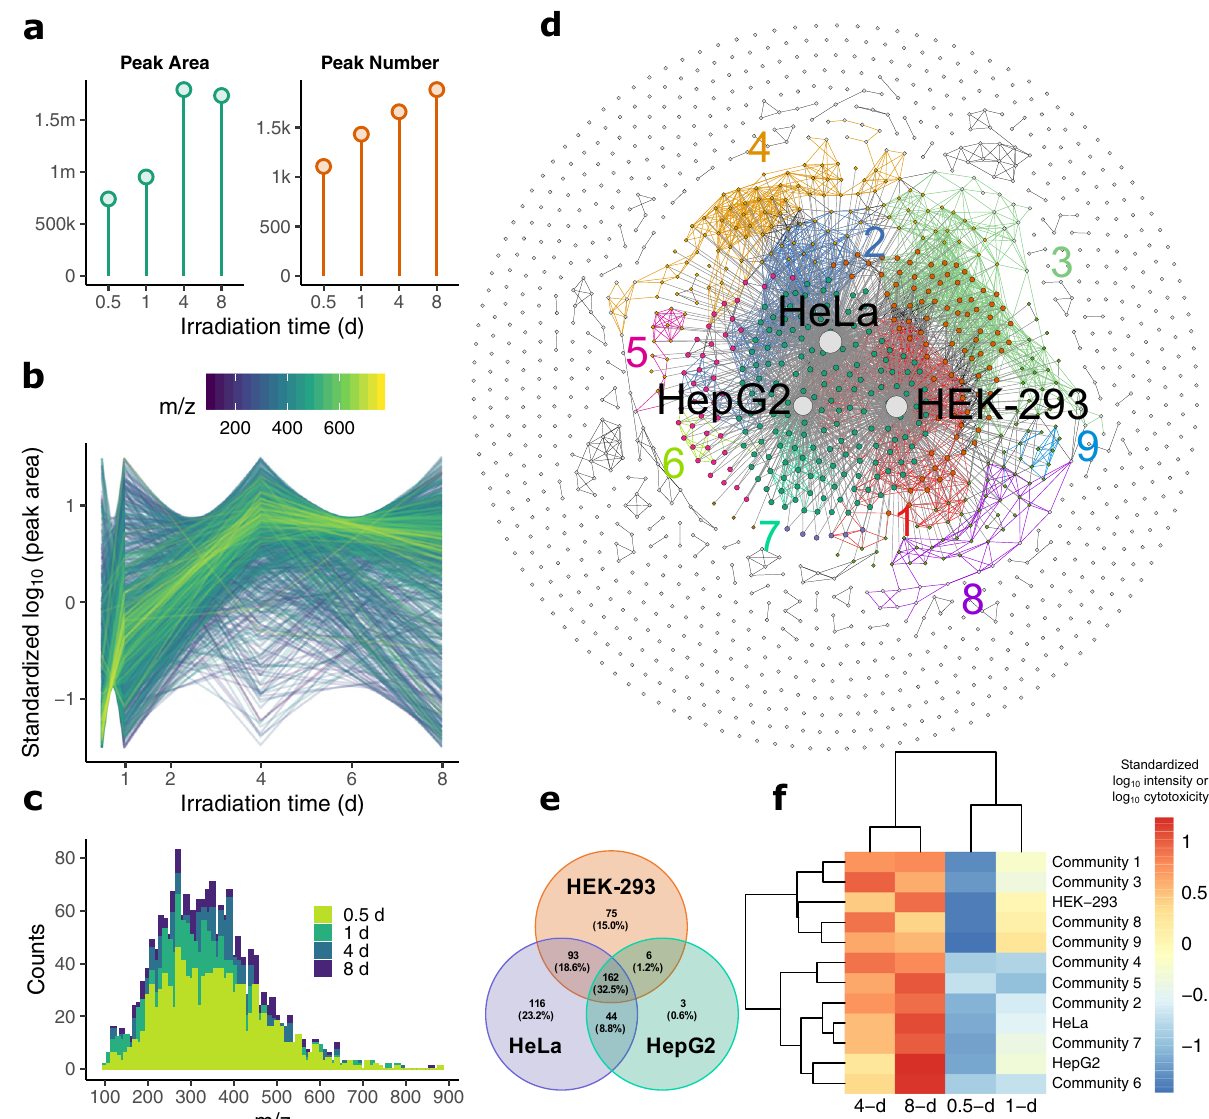
Fig. 4 Identi fi cation of the degradation products of laboratory-synthesized carbon dots (CDs). a The peak area and peak number of the photodegradation products increased with irradiation time (0.5, 1, 4, and 8 days). b The area/intensity of the peaks showed different patterns of variation with irradiation time. c The number of the peaks with an m/z between 270 and 350 was larger than other peaks. d Network analysis of the similarities in the formation kinetics of the 1431 photodegradation products/nodes obtained from a quadropole time-of- fl ight mass spectroscopy as well as the correlation between the formation kinetics of the products and time-related change in cytotoxicity. Twelve communities [nine of them with signi fi cant ( p < 0.05, two-tailed Pearson correlation analysis, see Source Data fi le for detailed p values) correlation to cytotoxicity were numbered] indicative of the connectivity between different nodes were obtained in which >10 nodes with similar formation kinetics clustered together. The products/nodes are differently colored (gray circle — uncorrelated to cytotoxicity, dark green circle — correlated to the cytotoxicity in all three cells, the other colored circles — correlated to the cytotoxicity in one or two cells) according to their correlation with the cytotoxicity in HEK-293, HeLa, and HepG2 cells. Based on the correlation intensity of each peak with cytotoxicity, three cell nodes were added, clarifying the signi fi cant ( p < 0.05, two-tailed Pearson correlation analysis, see Source Data fi le for detailed p values) association between the products in 9 of the 12 communities and the cytotoxicity in at least one cell line. Products/nodes in the nine communities were linked by lines with their color the same as that of the community number. e Distribution of the 499 cytotoxicity-correlated products in the Venn diagram of HepG2, HeLa, and HEK-293 cells. 162 products were correlated with the cytotoxicity in all three cell lines. f Clustering analysis of the correlation between the cytotoxicity in the three cell lines and the nine communities numbered in d . Source data are provided as a Source Data fi